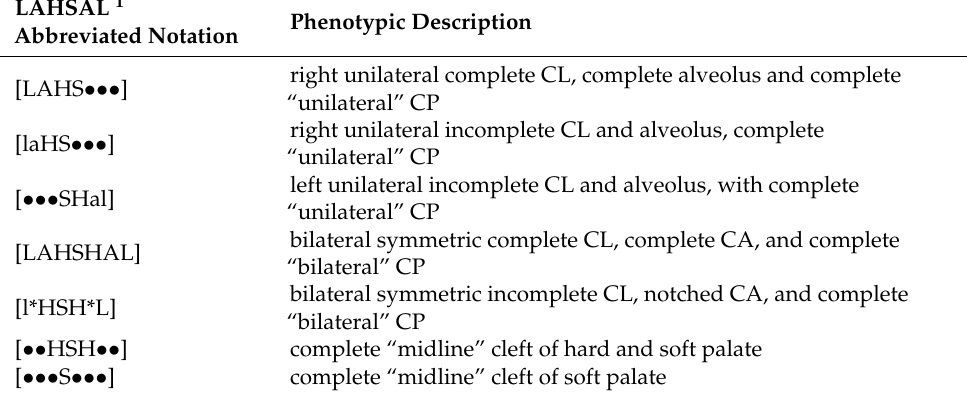
Table 1. Phenotypic description by LAHSHAL classification [CA: cleft alveolus; CL: cleft lip; CP: cleft palate; CL/P: cleft lip with or without